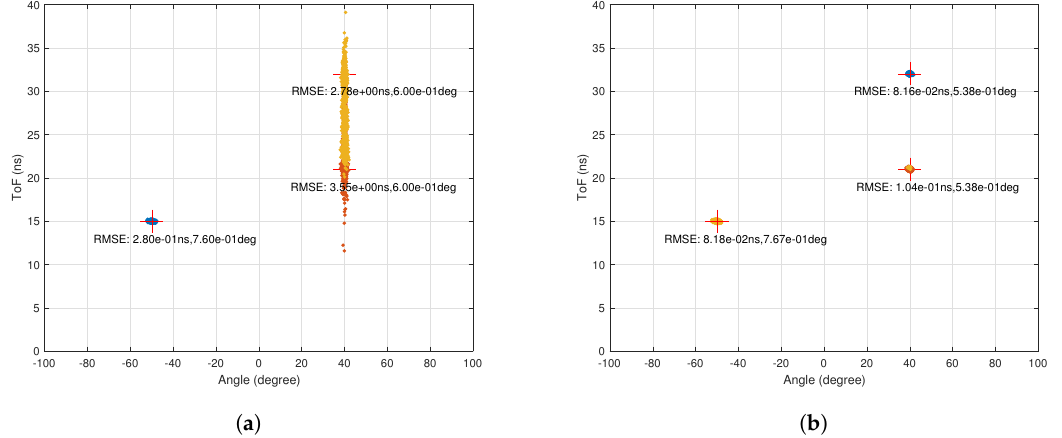
Figure 12. Ordering performance. ( a ) performance of MMP estimating AoA first for 1000 runs. The Average RMSEs for ToF and AoA are 2.20 ns and 0.65 deg; ( b ) performance of MMP estimating ToF first for 1000 runs. The RMSE for ToF and AoA are 0.089 ns and 0.61 deg.